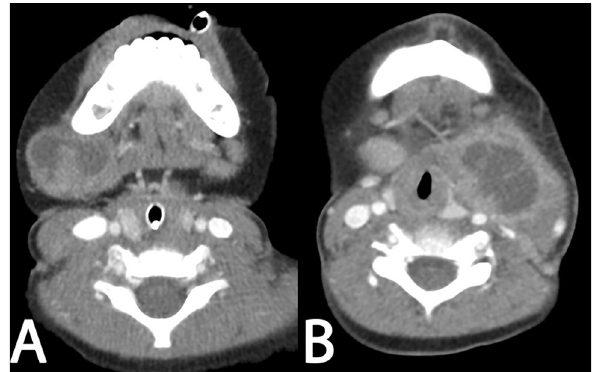
Figure 1. An example of a NTM Lymphadenitis diagnosis ( A ) and a pyogenic lymphadentis ( B